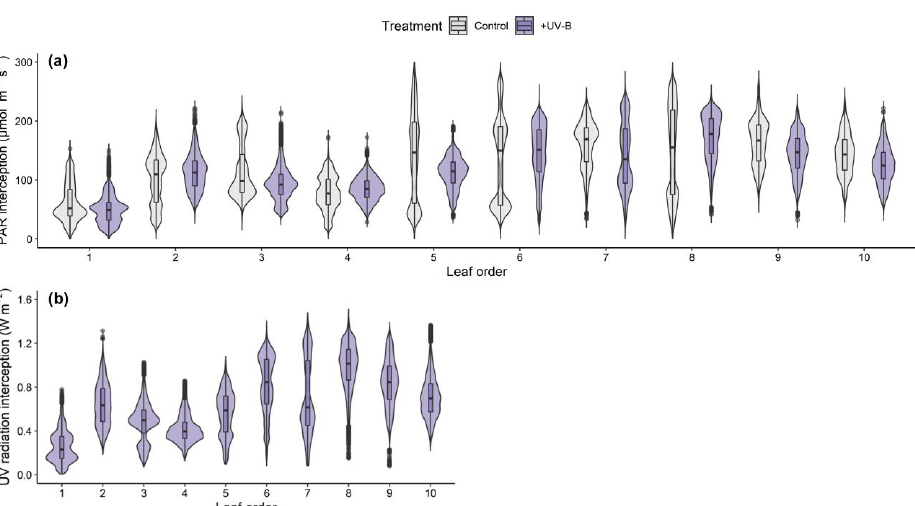
Figure 2. Distributions of PAR ( a ) and UV radiation ( b ) interceptions on the kales at different leaf orders in the control and UV-B treatments. PAR, photosynthetically active radiation in the range of 400–700 nm; UV, biological effective UV radiation in the range of 280–400 nm. The leaf order indicates the order from the oldest leaf at the bottom to the youngest leaf at the top in a whole plant. Based on kernel density estimation, the shape of the violin represents the frequencies of values. The boxes, horizontal lines, whiskers, and points indicate interquartile ranges, medians, 95% confidence intervals, and outliers,